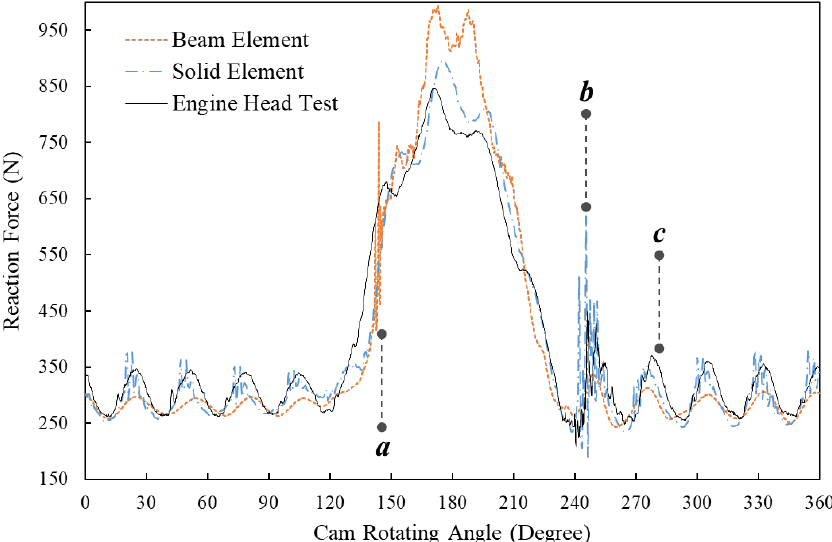
Figure 5. Comparison of the spring reaction forces at 5600 RPM engine speed of the dynamic FE results using beam elements and solid elements and the results of the engine head test.